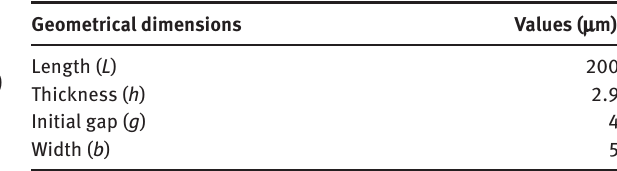
Table 1 Geometrical dimensions of the FGM microgripper.